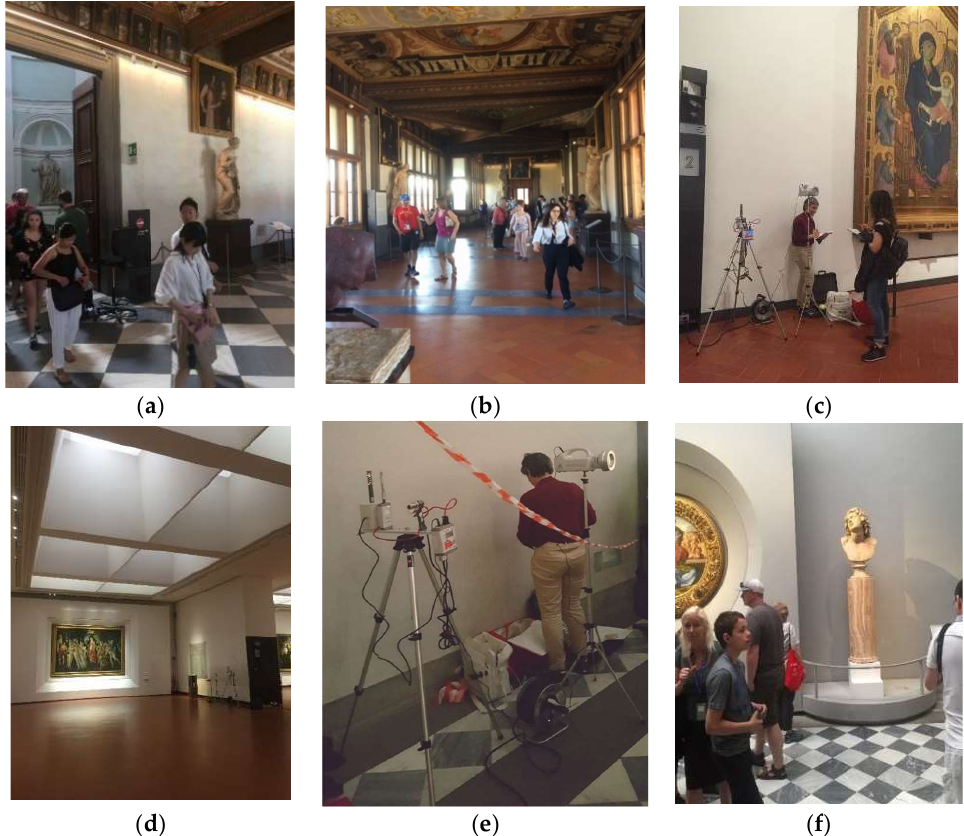
Figure 4. Analyzed rooms on the second floor of the Uffizi Gallery: ( a ) Entrance, ( b ) Verone II floor, ( c ) Room 2, ( d ) Room 10, ( e ) Room 35 and ( f ) Room 41. Measurement of the parameters mentioned in Section 2.1 (temperature, RH, CO 2 , VOCs, TBL and molds) were taken in sequence in each analyzed room, at the time of the greatest number of visitors, according to the schedule shown in Table 7. To evaluate the